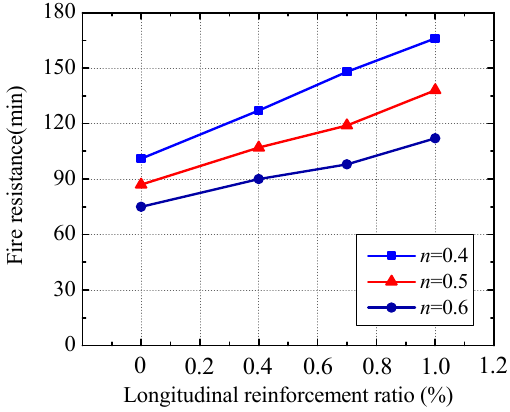
Figure 30. Variation of fire resistance with a longitudinal reinforcement ratio (fire insulation thickness = 10 mm).